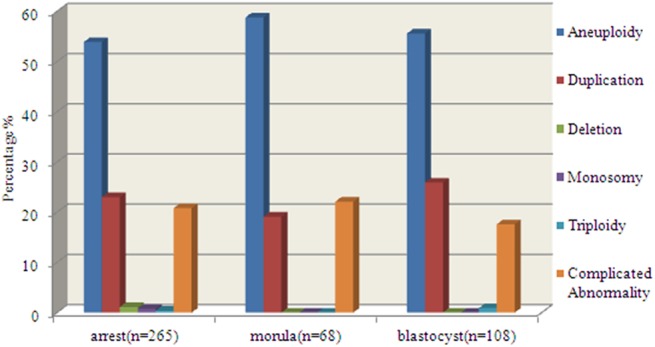
The distribution of abnormal molecular karyotypes in the subgroup of the arrest, morula and blastocyst.Blue represents the aneuploidy, red indicates the duplication and yellow indicates the complicated abnormalities and so on.